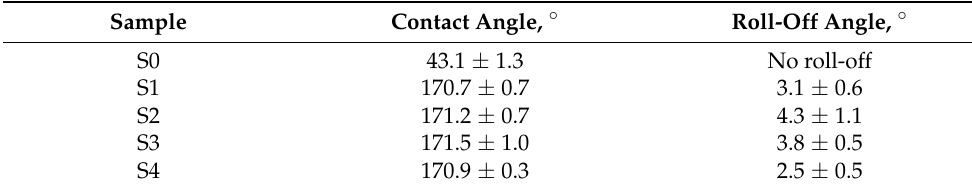
Table 2. Wettability characteristics of fabricated